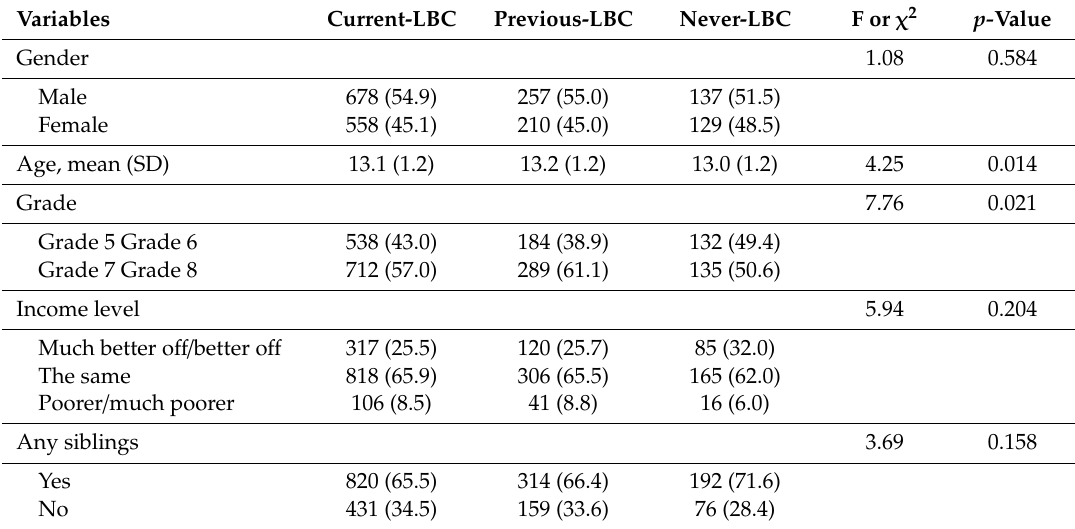
Table 1. Sample characteristics by parental migration status, n (%). LBC—left-behind